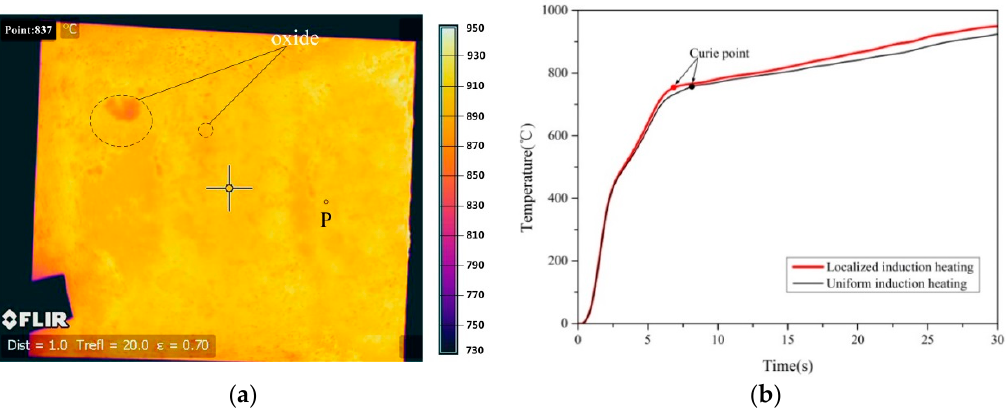
Figure 3. The temperature field and heating history curves of the steel blank due to different heating processes. ( a ) The temperature field with the measured point P and typical oxide location under uniform heating; and ( b ) the comparisons of heating history curves under two heating methods.